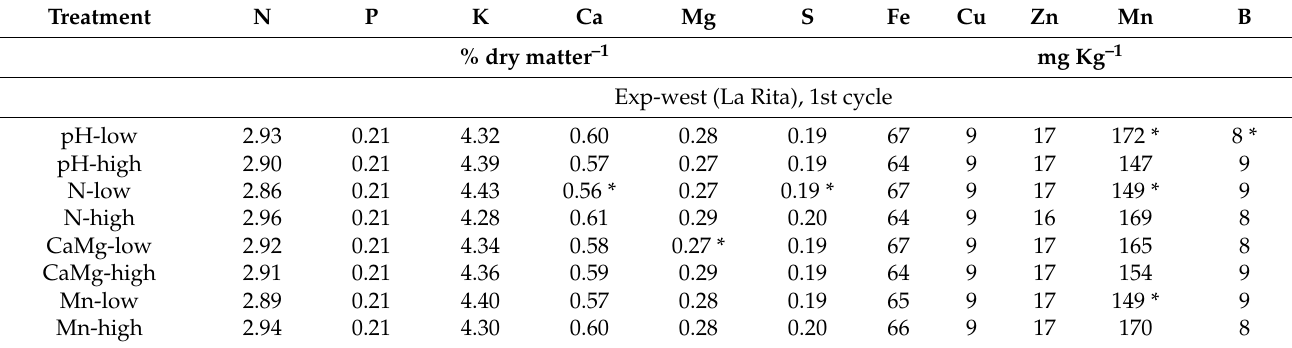
Table 3. Leaf nutrient concentrations at the first and the second crop cycles of Gros Michel banana inoculated with Foc Race 1 in relation with two levels (high and low) of four soil chemical properties (pH, N, CaMg and Mn) in two experiments (Exp-west and Exp-east) from two locations (La Rita and 28 Millas respectively) in the Costa Rican banana region. ( n = 32 per soil property per crop cycle and level of each soil chemical